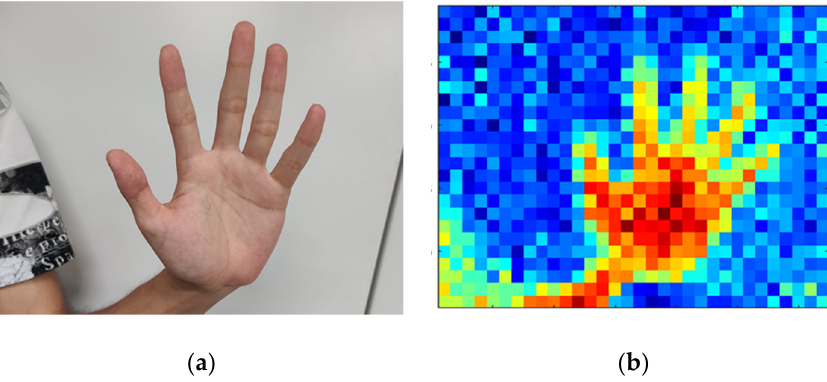
Figure 2. Example of far-infrared imaging: ( a ) original image; ( b ) far-infrared imaging.